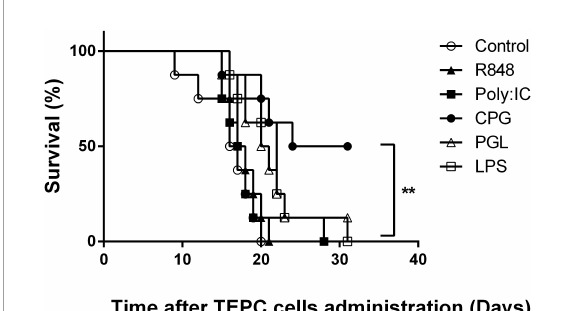
FIGURE1 Effect of toll-like receptor (TLR) ligand administration on early plasmacytoma growth. Survival of groups of BALB/c mice ( n = 8) either mock-treated (open circles) or treated with Poly (I:C) (closed squares), R848 (closed triangles), CpG-ODN (closed circles), lipopolysaccharide (LPS) (open squares), and peptidoglycan (open triangles) for two successive days before tumor administration. Groups were monitored daily after i.p. administration of plasmacytoma TEPC.1033.C2 cells. Experiment representative of three independent experiments. ** P = 0.0013 by Log-rank (Mantel–Cox)